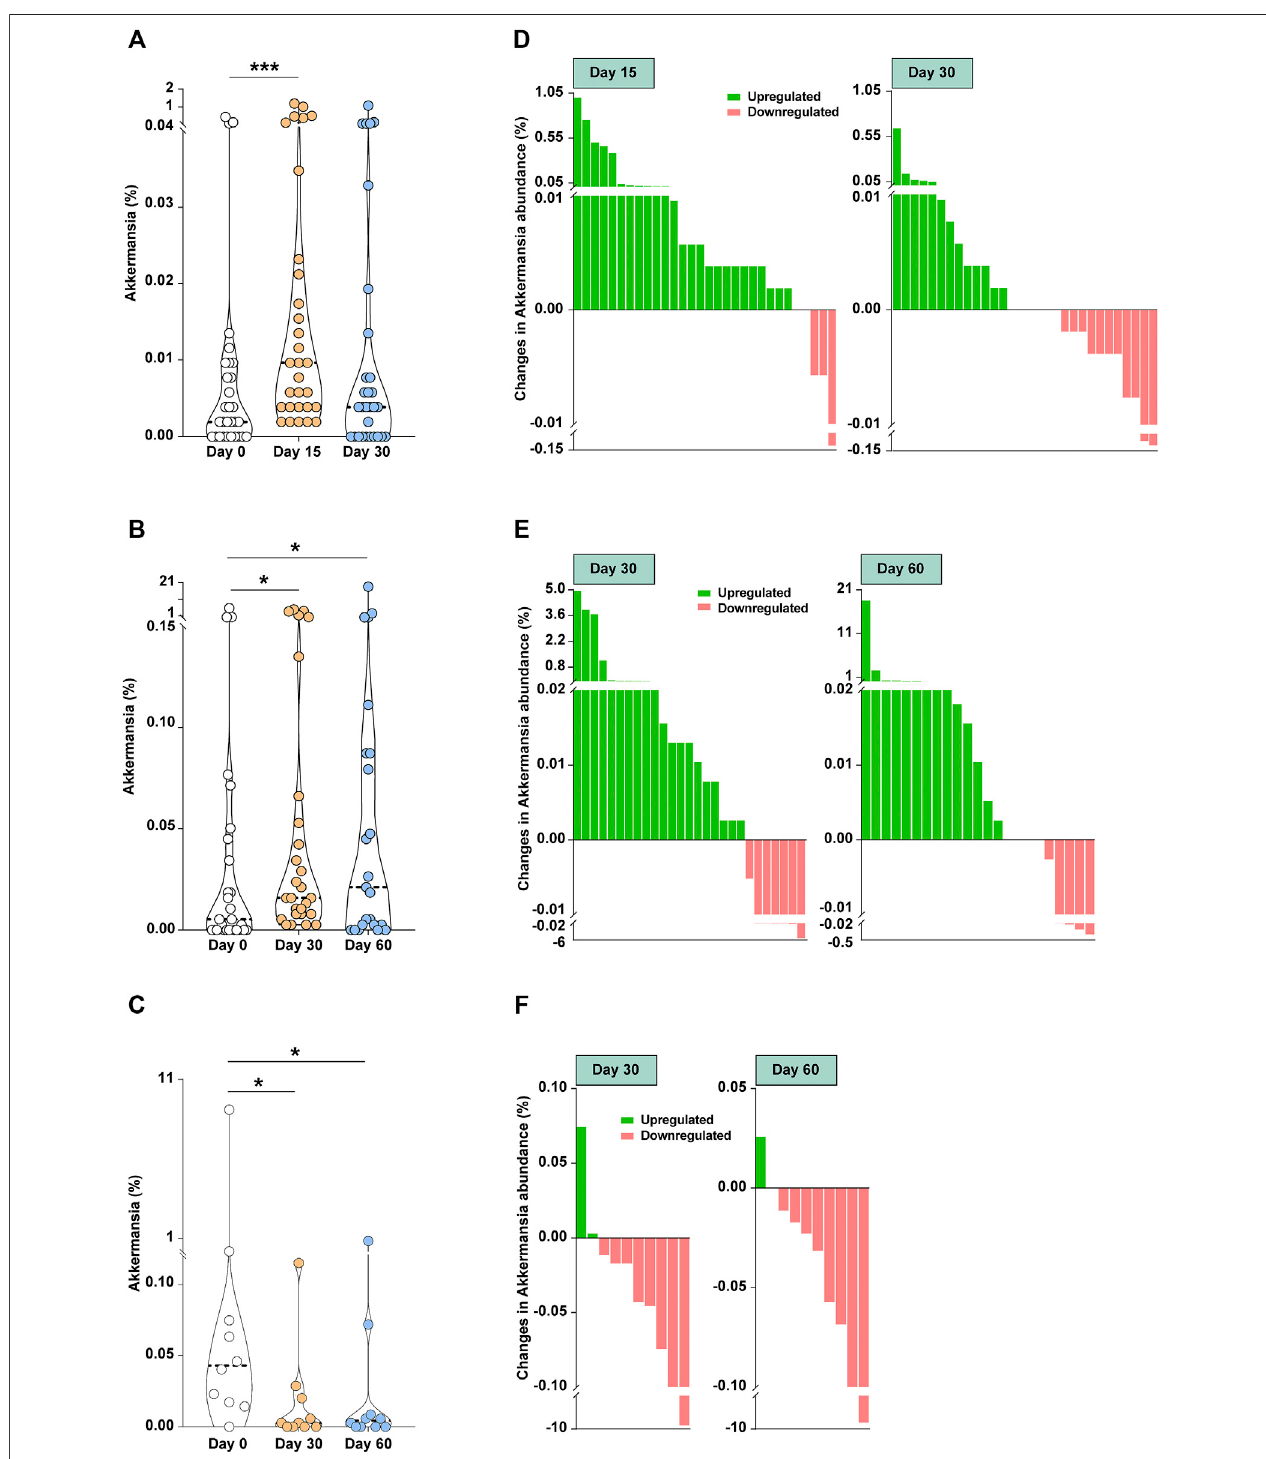
FIGURE 1 | Intermittent fasting upregulated the Akkermansia municiphila species abundance in fecal samples obtained in two independent adult cohorts (for details, see reference 6). (A) Results showing the dynamics of mean abundance of the bacterium from a cohort of young adult males undergoing intermittent fasting. Fecal samples were collected before (day 0; n = 30), during (day 15; n = 30) and at the end of intermittent fasting (day 30; n = 30). *** p < .001 by Wilcoxon-singed rank test. (B) The dynamics of mean abundance of the bacterium from a middle-aged cohort undergoing intermittent fasting. Fecal samples were collected before (day 0; n = 27), at the end of (day 30; n = 27), and 30 days following the cessation of intermittent fasting (day 60; n = 23). * p < 0.05 by Wilcoxon-singed rank test. (C) The